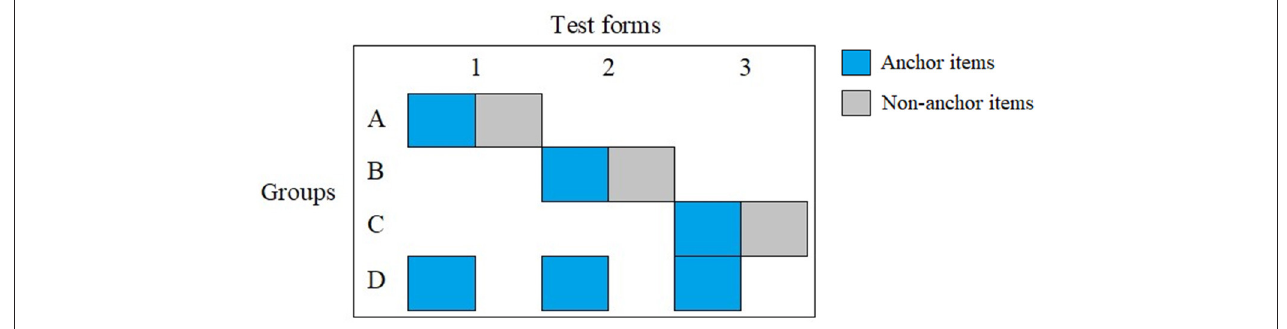
FIGURE 1 | Linking design employed in the current